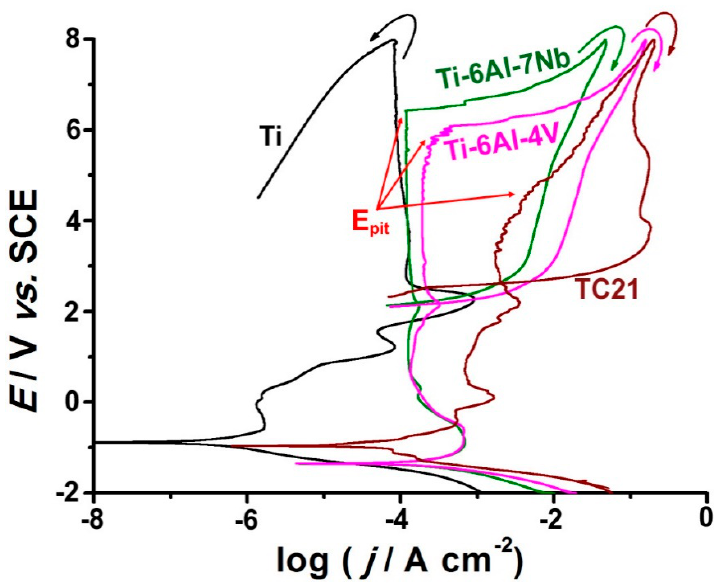
Figure 8. Cyclic polarization curves recorded for the studied alloys in 0.9% NaCl solutions at a scan rate of 1.0 mV s -1 at 37 °C.